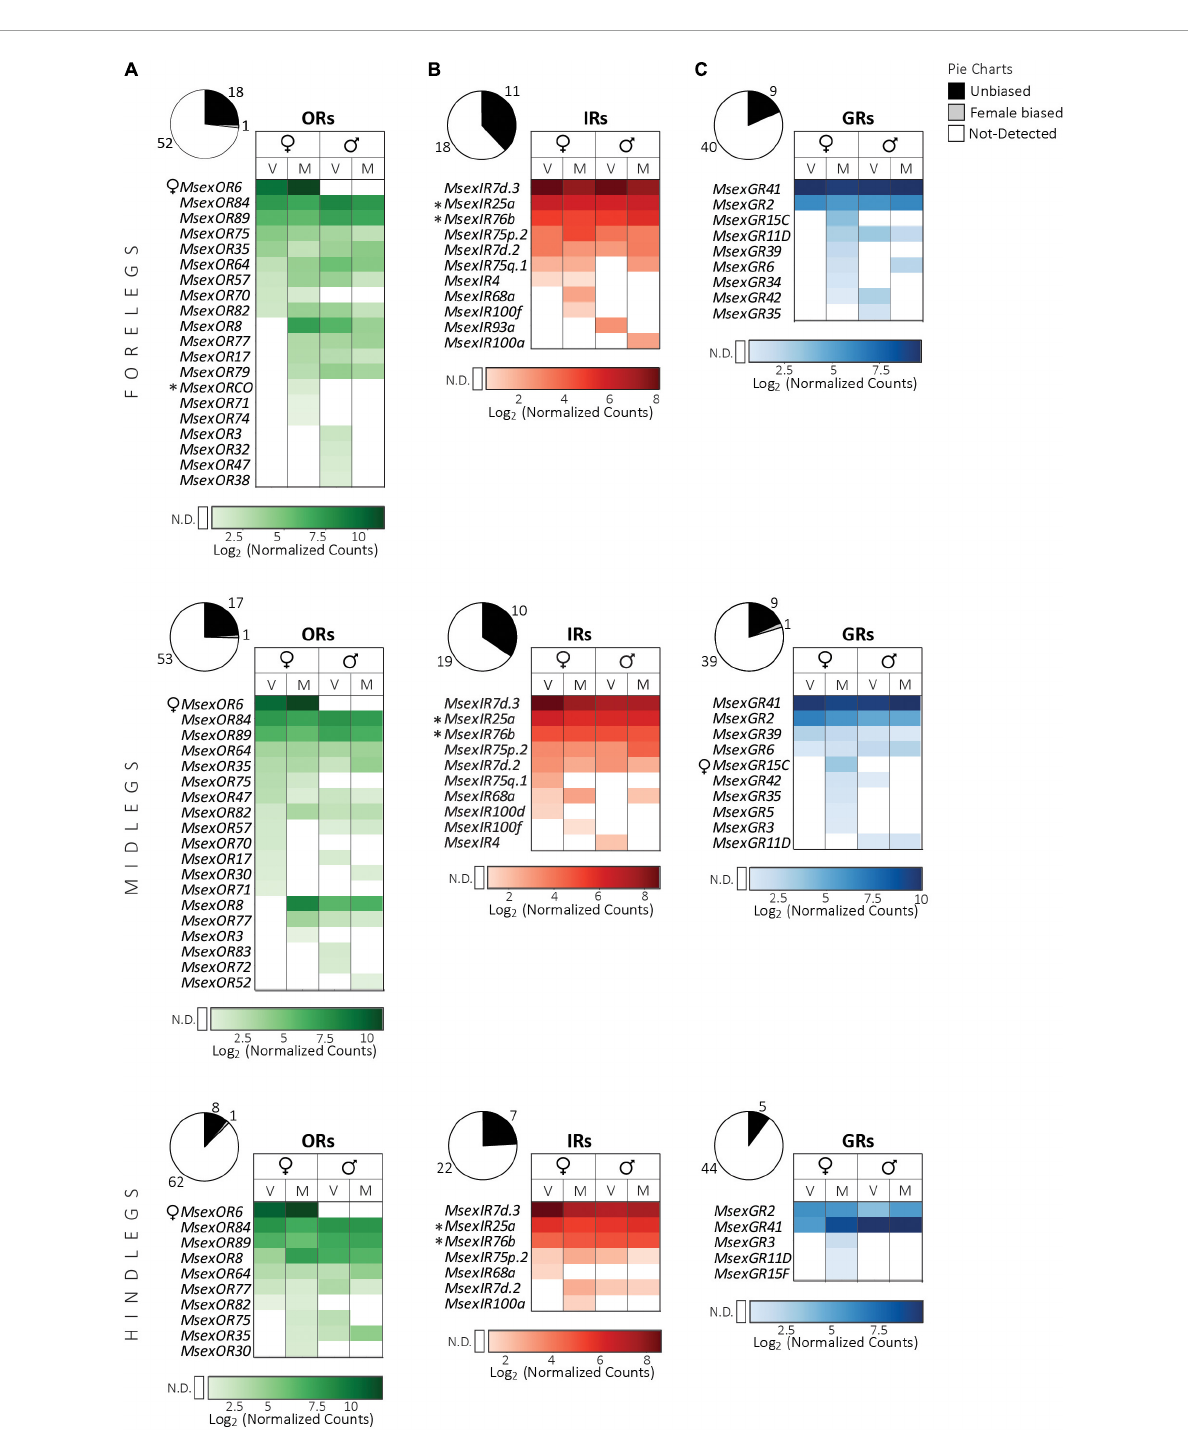
FIGURE3 Expression of chemosensory receptor genes in the legs of adult M. sexta (top panel, forelegs; middle panel, midlegs; bottom panel, hindlegs). (A) Odorant receptors, (B) ionotropic receptors, (C) gustatory receptors. Pie charts depict the percentage of expressed genes (absolute numbers next to the charts) of each receptor family (see legend on top right). Heatmaps were created separately for each receptor family using the log 2 of the geometric mean ( n = 3 biological replicates) of normalized counts obtained from the NanoString assay (see section “Materials and methods”). Light to dark shades indicate low to high counts (see color bar at bottom of each heatmap); white cells indicate no detection (N.D.) of transcripts (for a definition see section “Materials and methods”). Columns represent female and male moths of different mating states (V: virgin, M: mated). Rows represent receptors that were expressed in the legs of at least one of the four groups and are sorted first according to values in virgin females, followed by mated females, virgin males and mated males. Symbols next to receptor gene names: ∗ , OR or IR co-receptors; , female-biased receptors (FDR corrected p < 0.05, nested ANOVA). Mating states of males and females did not have a significant effect on receptor gene expression (FDR corrected p > 0.05, nested ♀